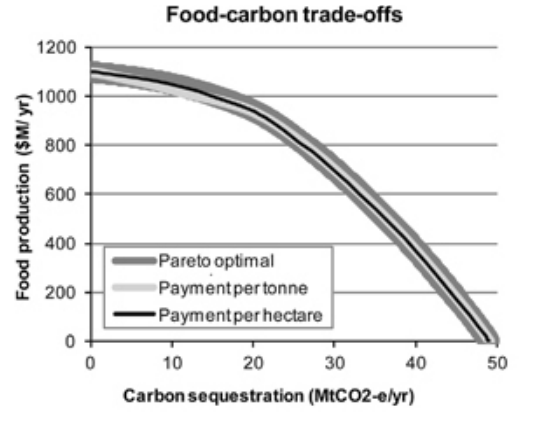
Fig. 5 . Food-carbon trade-offs for the payment per tonne and payment per hectare schemes. Trade-offs were calculated using the median scenario parameter values (R = 0.8, ec = A$2000/ha, tmc = A$70/ha/yr, r = 7%) and values of carbon sequestration are an annual average over a 64-year